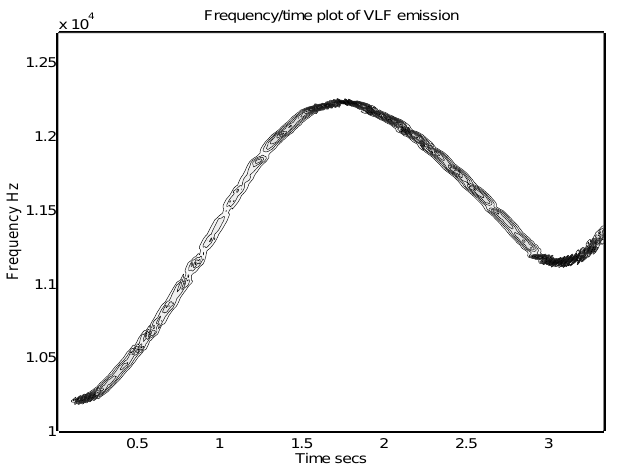
Fig. 17. Run 3. Omega triggered oscillating frequency emission. This kind of behaviour requires a high linear growth rate, here 110dB/s.